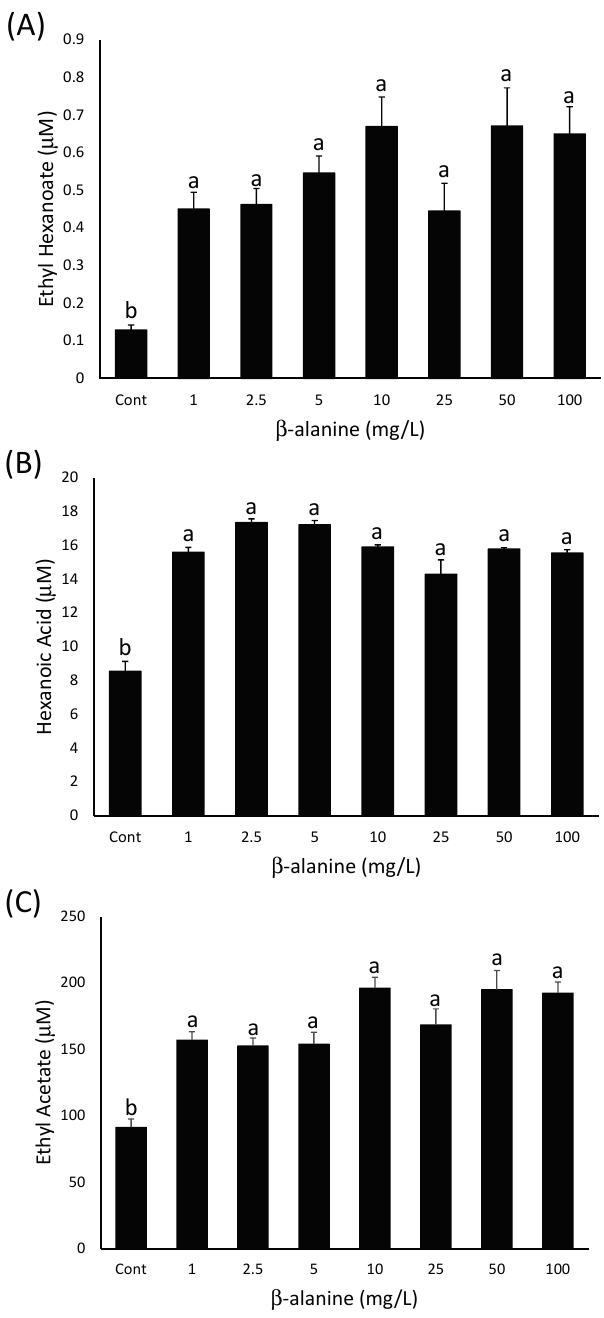
Figure 7. The concentration of ( A ) ethyl hexanoate, ( B ) hexanoic acid and ( C ) ethyl acetate in model wines produced after the addition of increasing amounts of β -alanine as indicated on the x-axis. Histograms represent the mean values (n = 3) and error bars show standard errors. Different letters (e.g., a, b) denote significant differences between treatments at p < 0.05 using ANOVA followed by Tukey’s post hoc